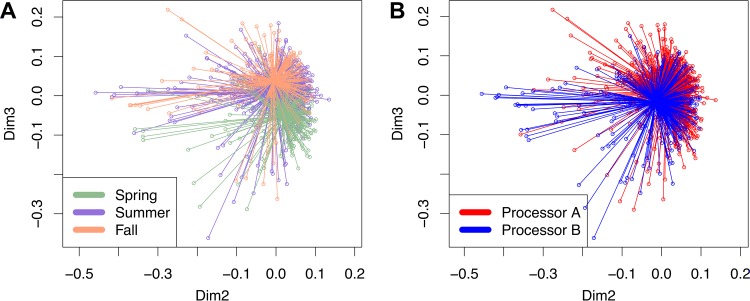
PCoA of the weighted UniFrac distances between bacterial communities in raw milk tankers. Rarefaction at 15,000 sequences per sample preceded UniFrac analysis. Milk samples are colored by (A) season (spring = light green, summer = purple, and fall = orange) and (B) processor (A = red and B = blue). Dimension 2 (Dim2) and dimension 3 (Dim3) show changes in the overall community composition between seasons but not between processors.